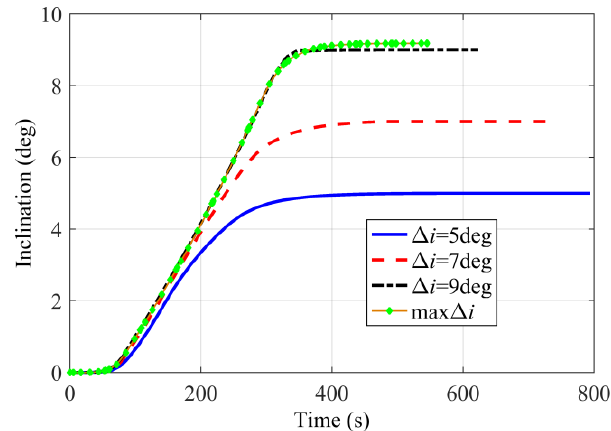
Figure 15. Inclination profiles with different inclination increment constraints.